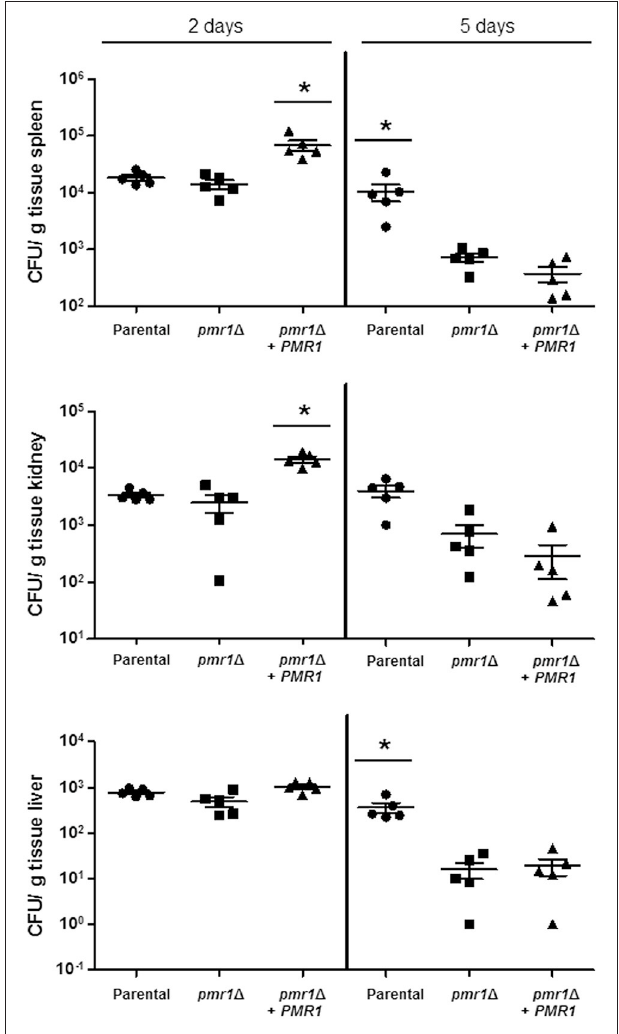
FIGURE 11 | The C. guilliermondii pmr1 1 null mutant has decreased virulence in the mouse model of systemic candidiasis. Wild-type BALB/c mice were infected i.v. with 2 × 10 7 cells of either C. guilliermondii KU141 (Parental), HMY134 ( pmr1 1 ), and HMY138 ( pmr1 1 + PMR1 ), and the fungal burdens in the spleen, kidneys and liver were determined at 2- or 5-days post-infection. Data are expressed as colony forming units (CFU)/g tissue (mean ± SEM). Results are pooled data from 2 separate experiments with 5 mice per group. * P < 0.05.